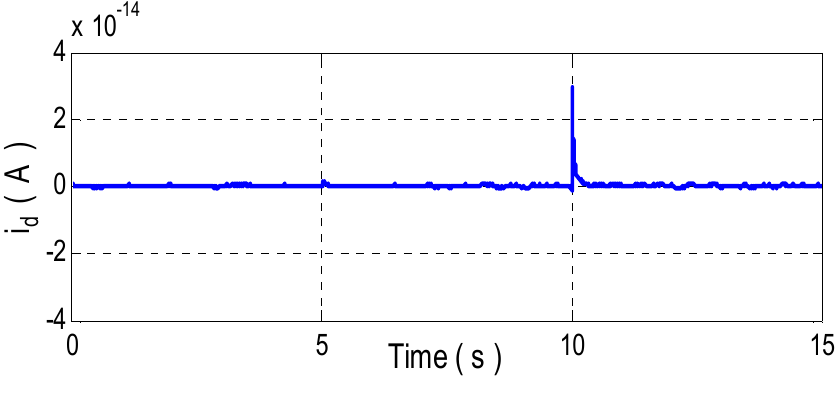
× 𝑖 in Equation (3). (cid:3031) (cid:3044)